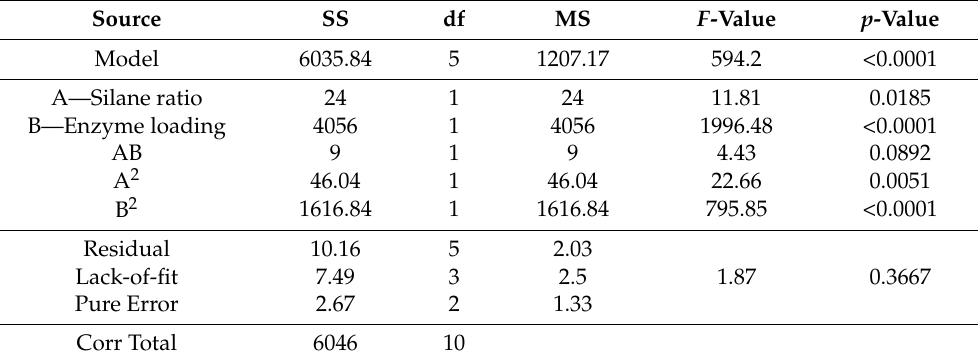
Table 2. Analysis of variance for the quadratic model for ester yield